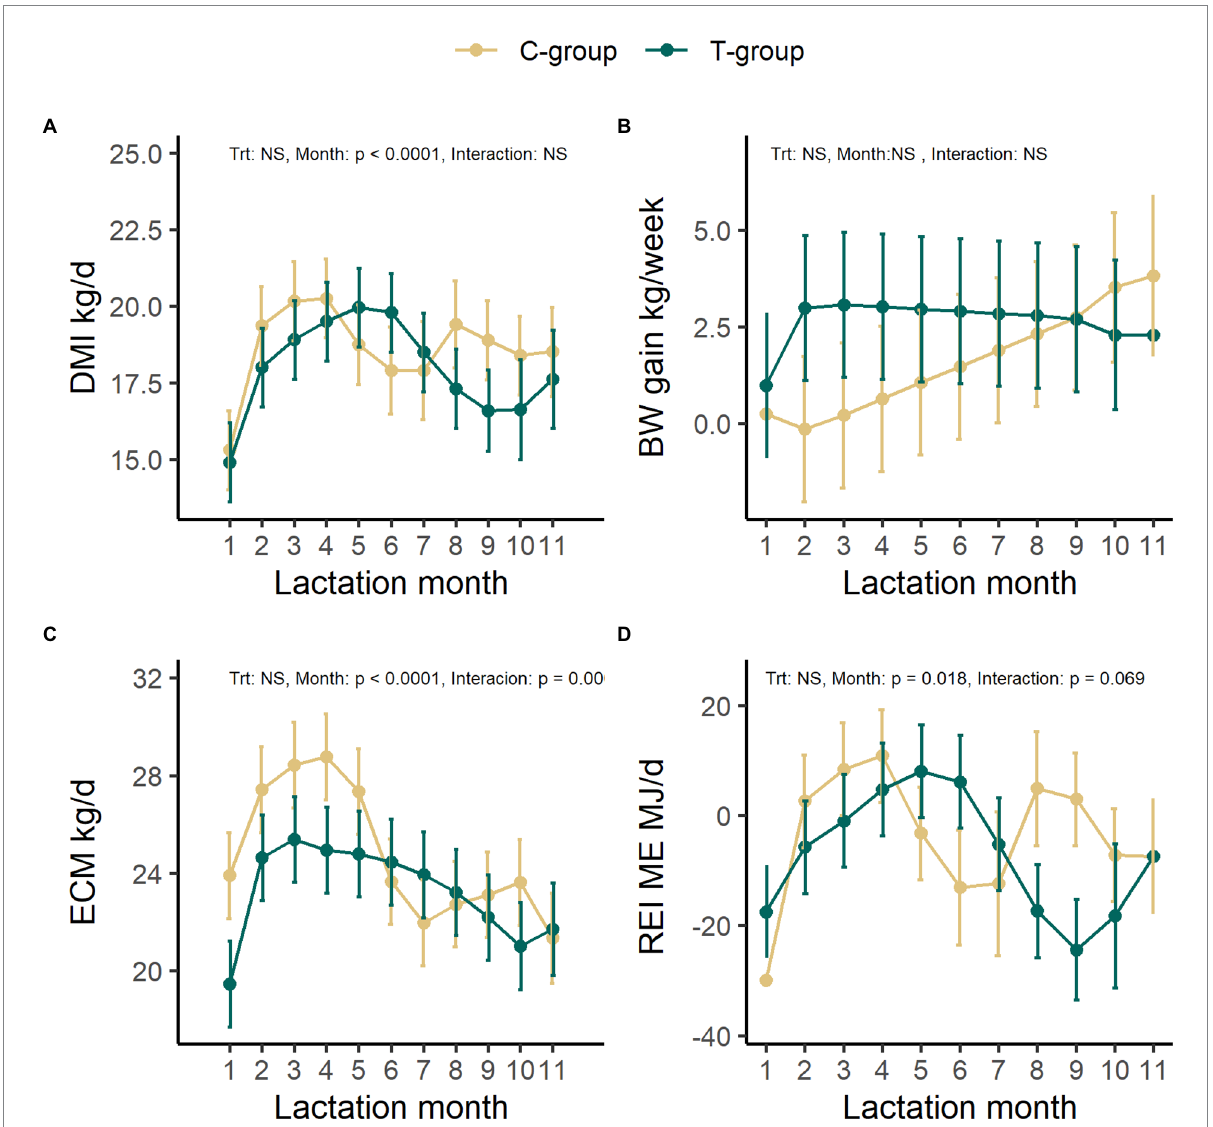
FIGURE 6 The average feed dry matter intake (DMI, kg/day) (A) , average weekly body weight gain (B) , energy-corrected milk yield (ECM, kg/day) (C) , and residual energy intake (REI) (D) in treatment (T-group) and control (C-group) cows during the 1 st lactation period. Data is presented in least square means ± standard